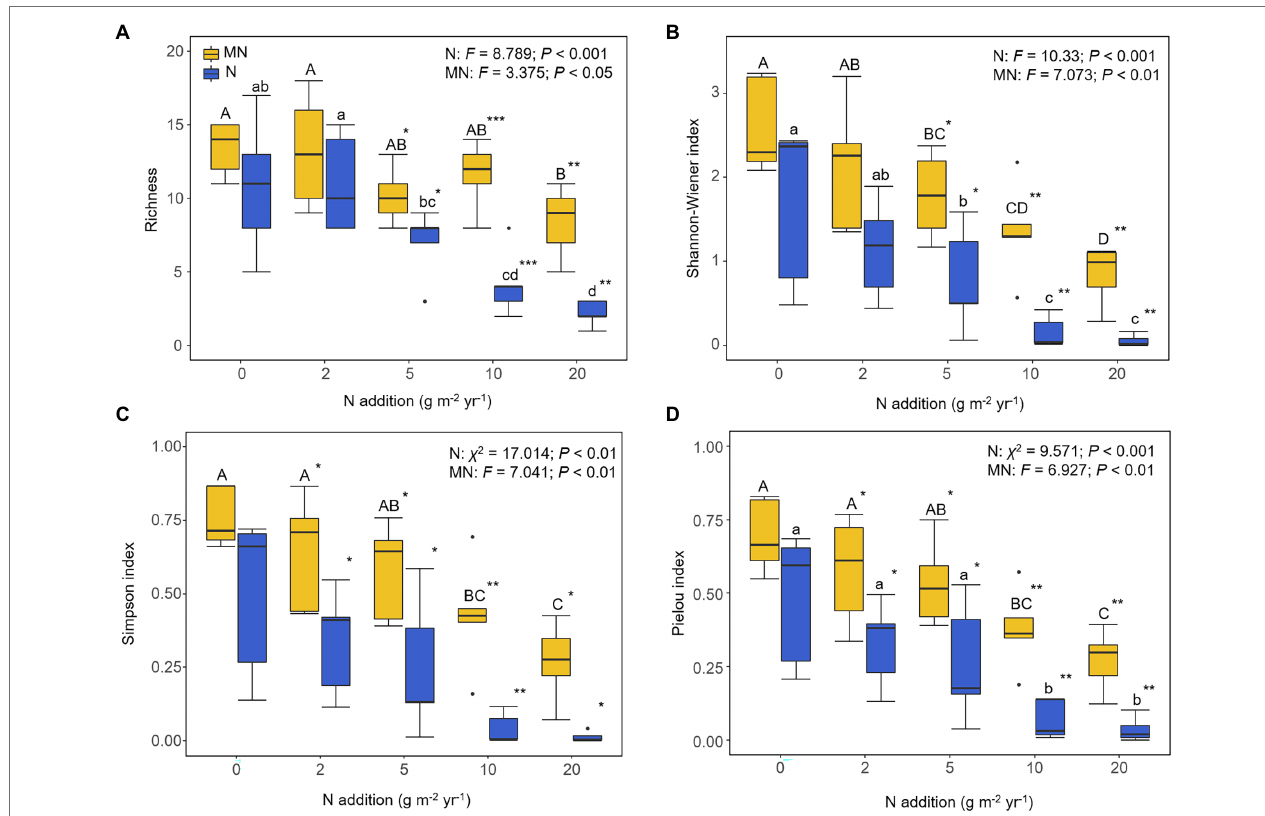
FIGURE 1 | Effects of nitrogen addition (N) and mowing (M) on plant α -diversity: (A) plant richness, (B) plant Shannon-Wiener index, (C) plant Simpson index, and (D) plant Pielou index. One-way ANOVA was used to test the response of plant α -diversity in each nitrogen addition and mowing treatment. Different lower- and upper-case letters denote significant difference ( p < 0.05) among nitrogen addition rates in the mown and unmown treatments. The symbol “*” at the right corner of lower- and upper-case letters indicates a significant difference between mown and unmown treatments at each nitrogen addition rate (* p < 0.05, ** p < 0.01, *** p < 0.001). Treatments 0, 2, 5, 10 and 20 denote nitrogen addition with 0, 2, 5, 10 and 20 g m − 2 yr. − 1 ,